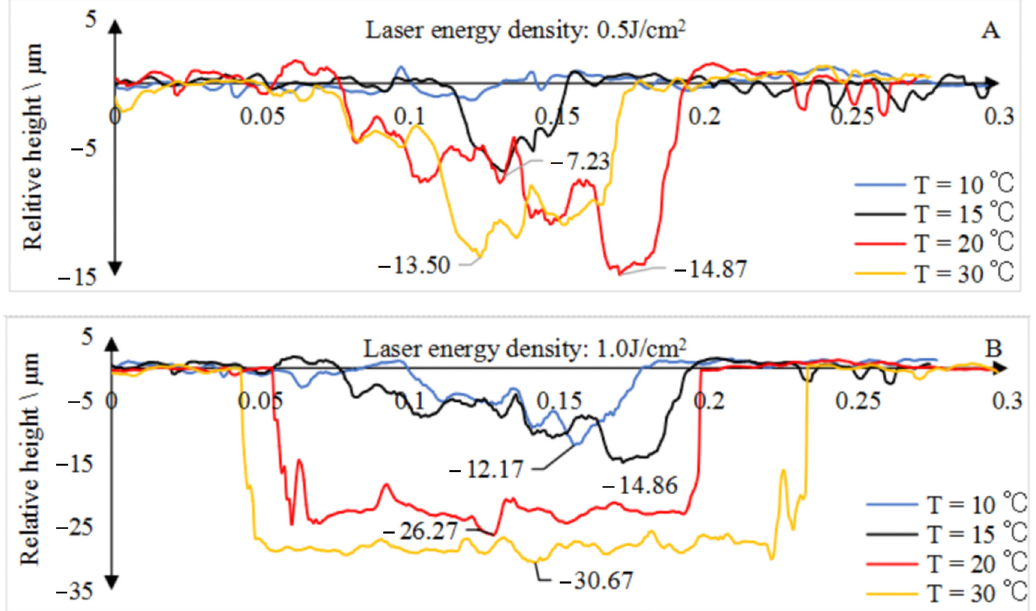
Figure 14. Damage pits profile after laser irradiation with different temperature. The laser energy density in ( A ) is 0.5 J/cm 2 ; ( B ) is 1.0 J/cm 2 . Table 10. Width and depth of laser damage pit of temperature